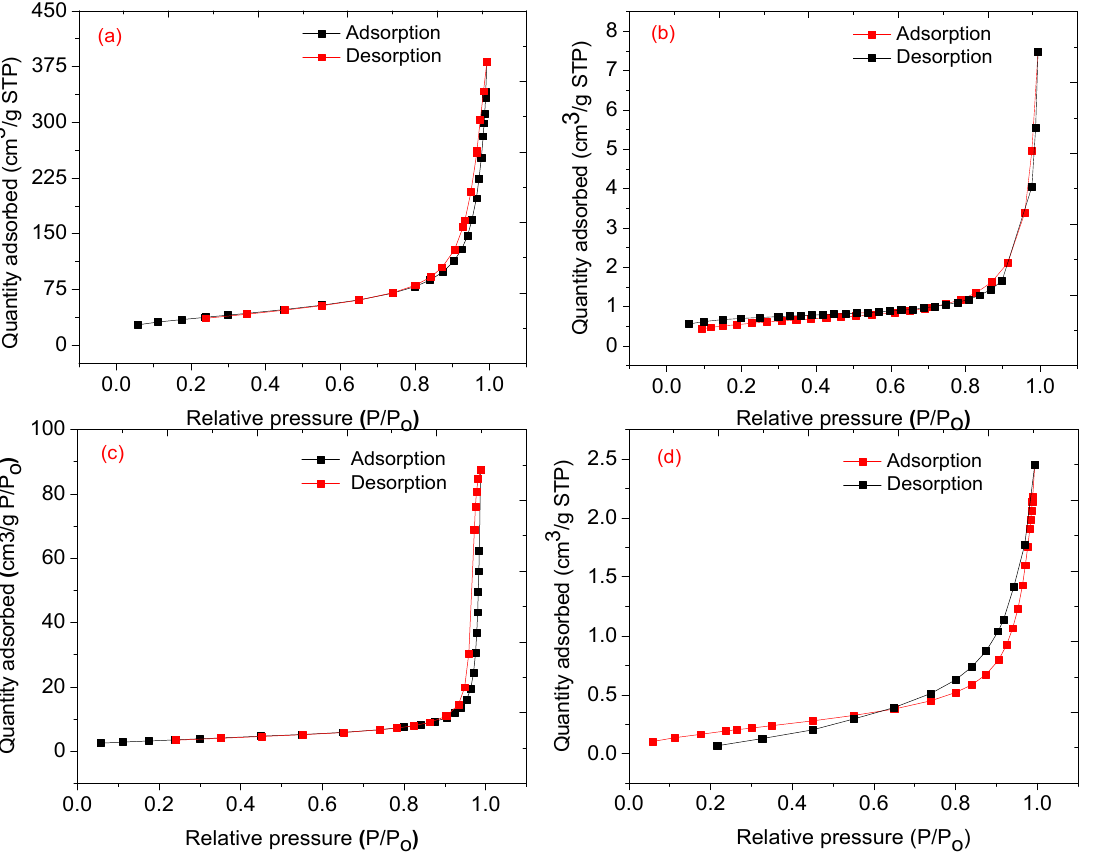
Figure 9. Nitrogen adsorption-desorption isotherms of ( a ) CNPs, ( b ) CA, ( c ) NiO nanoparticles, and ( d ) 1:1:3 mass ratio NiO-CNPs-CA.